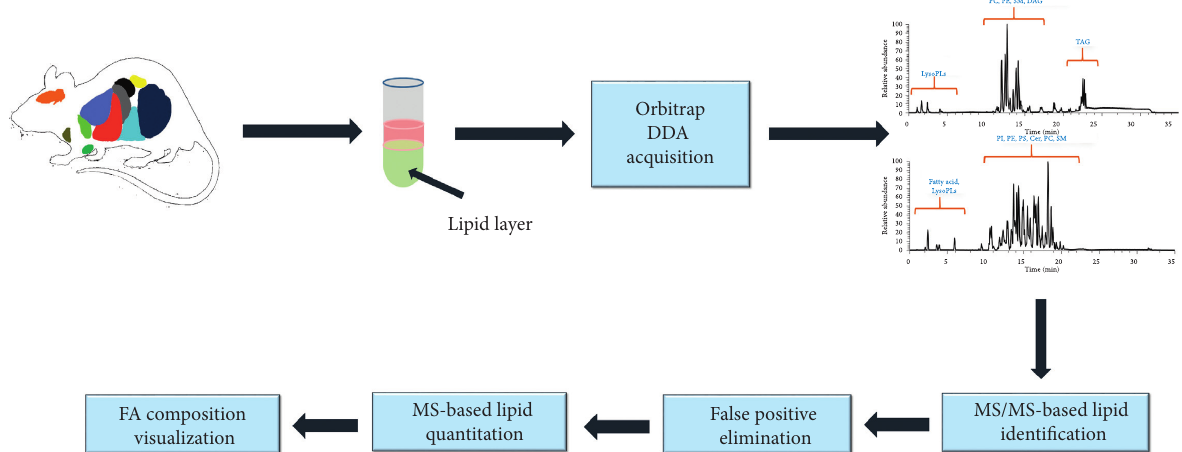
Figure 1: Schematic showing the workflow to perform lipidomics analysis for